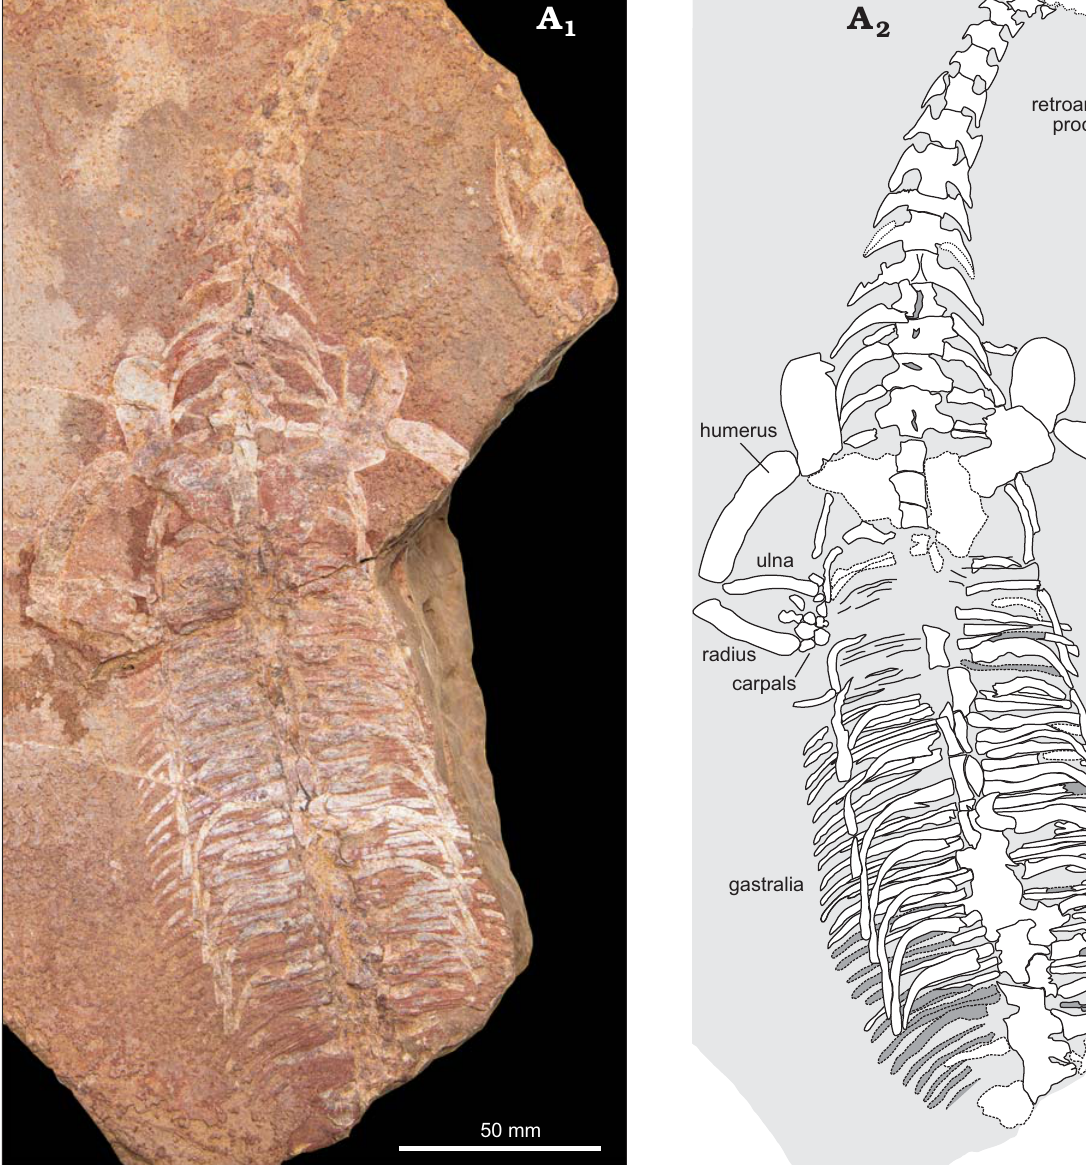
Fig. 2. Unidentified pachypleurosaur (CMLV_1) from the Triassic of Myanmar, in dorsal view. Much of the neck, pectoral girdles, and trunk are preserved, along with part of the skull and forelimbs. The pelvis, hindlimbs, and tail are not preserved. Photograph (A ments see Table